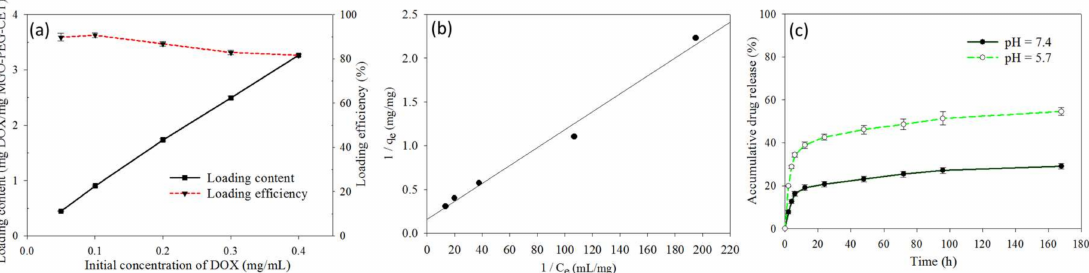
Figure 4. ( a ) Drug loading content and loading efficiency when a DOX solution with different initial concentration was mixed with an equal volume of 0.1 mg/mL MGO-PEG-CET; ( b ) The drug loading was satisfactorily modeled with the Langmuir adsorption isotherm where C e is the equilibrium DOX concentration in the solution and q e is the adsorbed DOX amount; and, ( c ) The release of DOX from MGO-PEG-CET/DOX in pH 7.4 and 5.7 PBS at 37 ◦